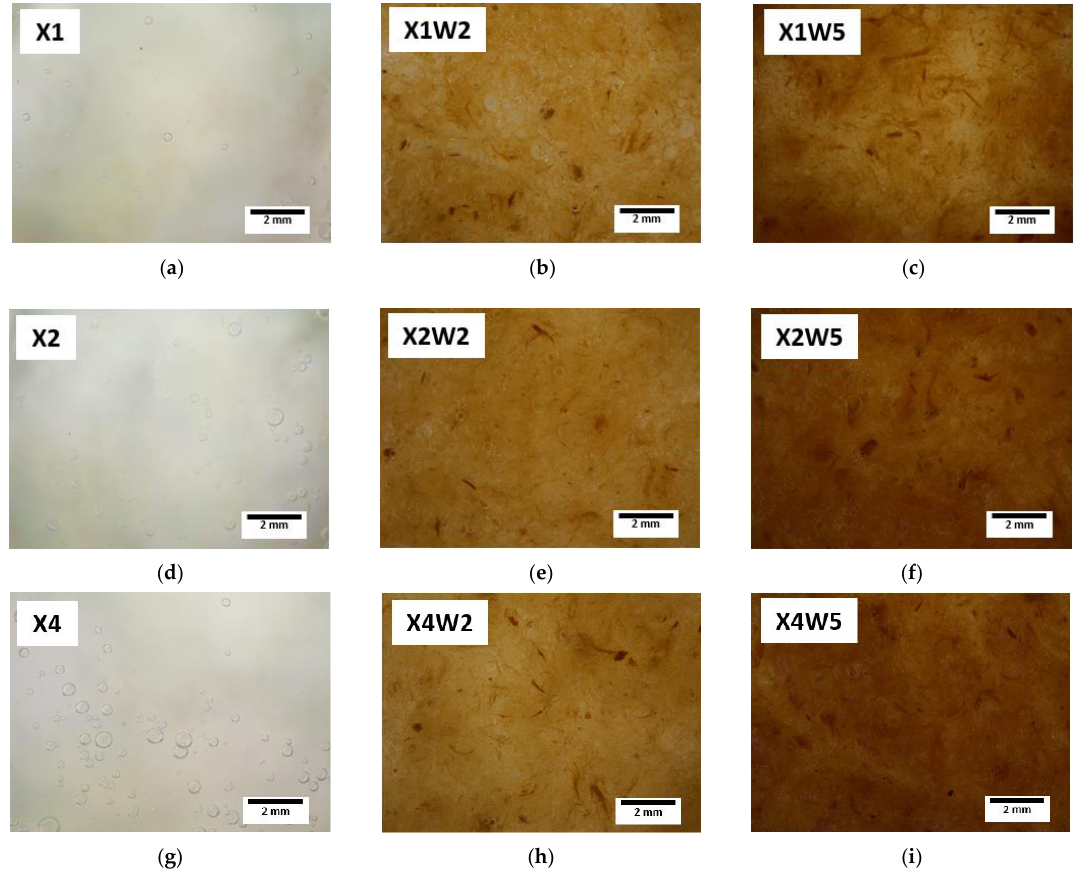
Figure 3. Light microscope images of the prepared hydrogel samples: ( a ) X1, ( b ) X1W2, ( c ) X1W5, ( d ) X2, ( e ) X2W2, ( f ) X2W5, ( g ) X4, ( h ) X4W2, and ( i ) X4W5.